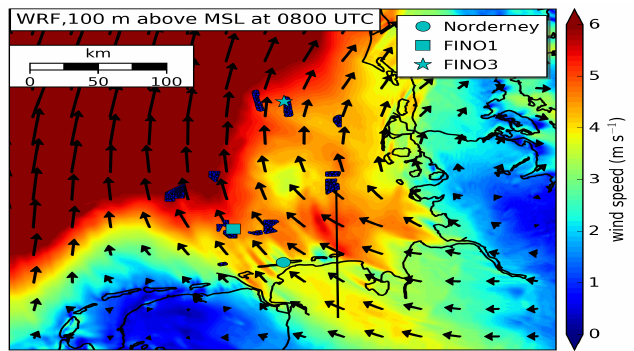
Figure 13. WRF simulation of 2 June 2017 showing the cross section in almost north–south direction, from land to the wind park. ( a ) shows 08:00 UTC, ( b ) shows 09:00 UTC. The area above land is indicated in red, up to a distance of 35km. The lower figure shows the horizontal distribution of wind speed in the German Bight at 100 m